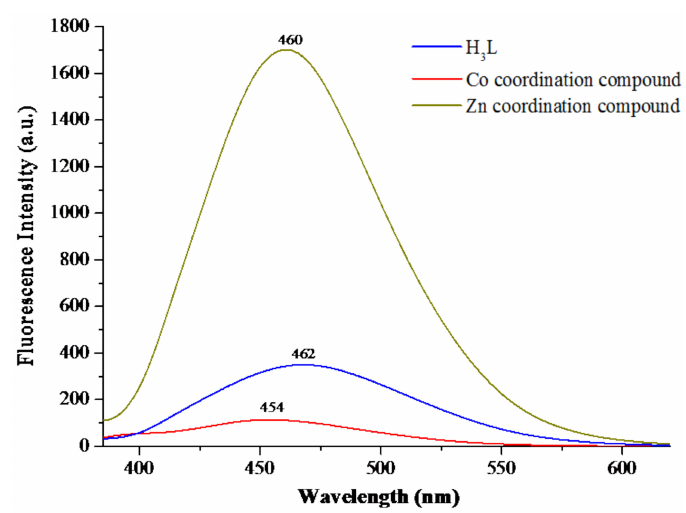
Figure 7. Emission spectra of H 3 L (c = 1 × 10 -5 M, λ ex = 370 nm) and its coordination compounds 1 and 2 in dilute MeOH solutions at room temperature.